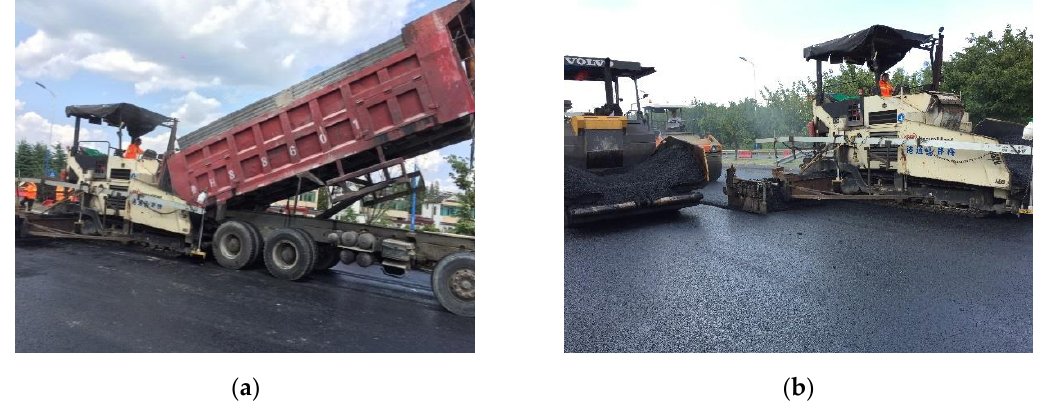
Figure 14. Paving process: ( a ) asphalt mixture feeding; ( b ) placement and paving.